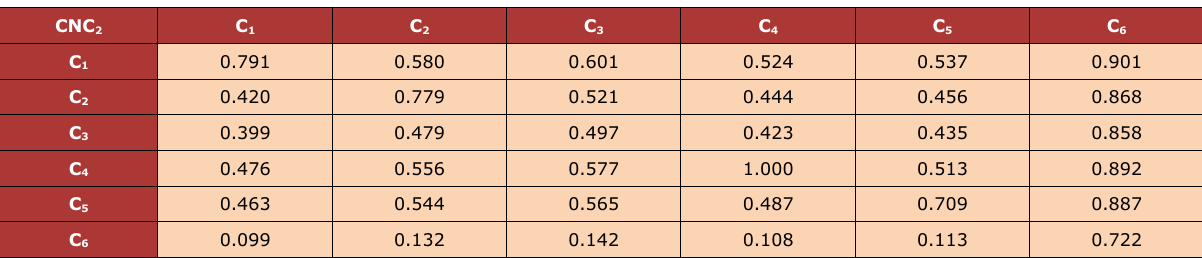
Table 11. Pair-wise comparison of criteria with respect to A 2